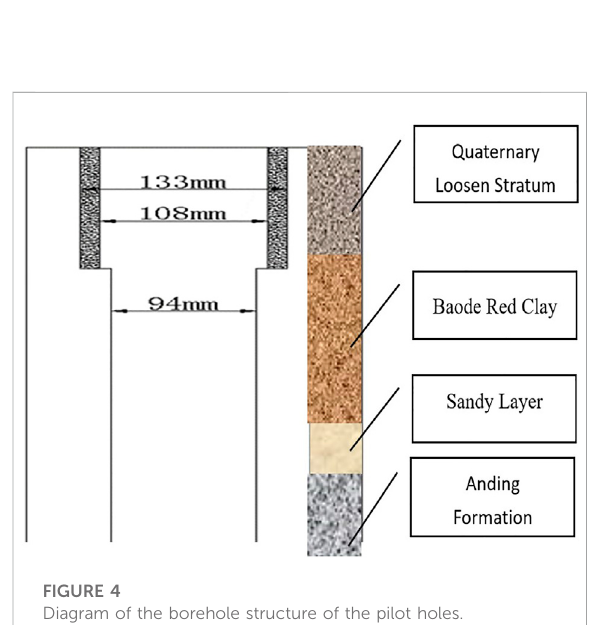
FIGURE 4 Diagram of the borehole structure of the pilot